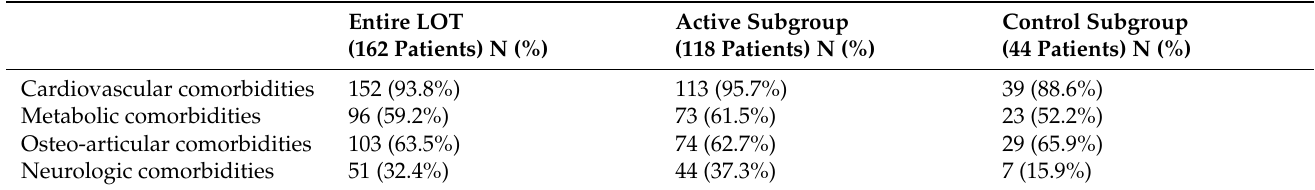
Table 7. Analysis of the 4 most frequent disease categories in the study group and the two research subgroups (the active group of 118 dementia patients and the control group of 44 cognitively nor- mal patients) indicate an important prevalence of cardiovascular comorbidities in more than 90% of